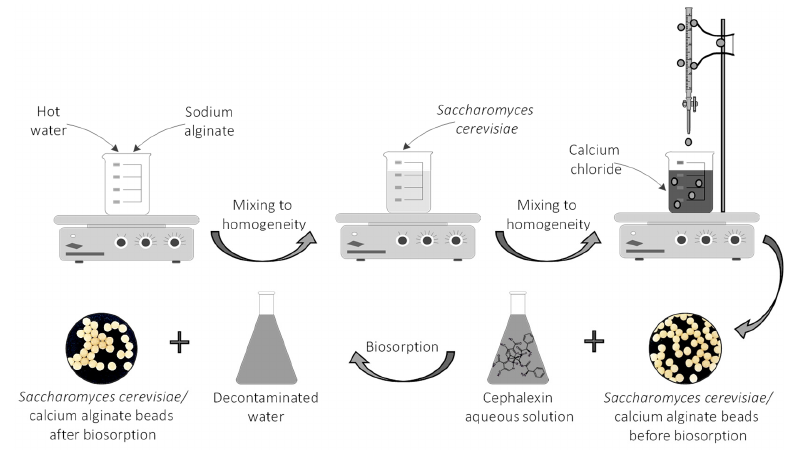
Figure 2. Schematic representation of the CPX biosorption process.